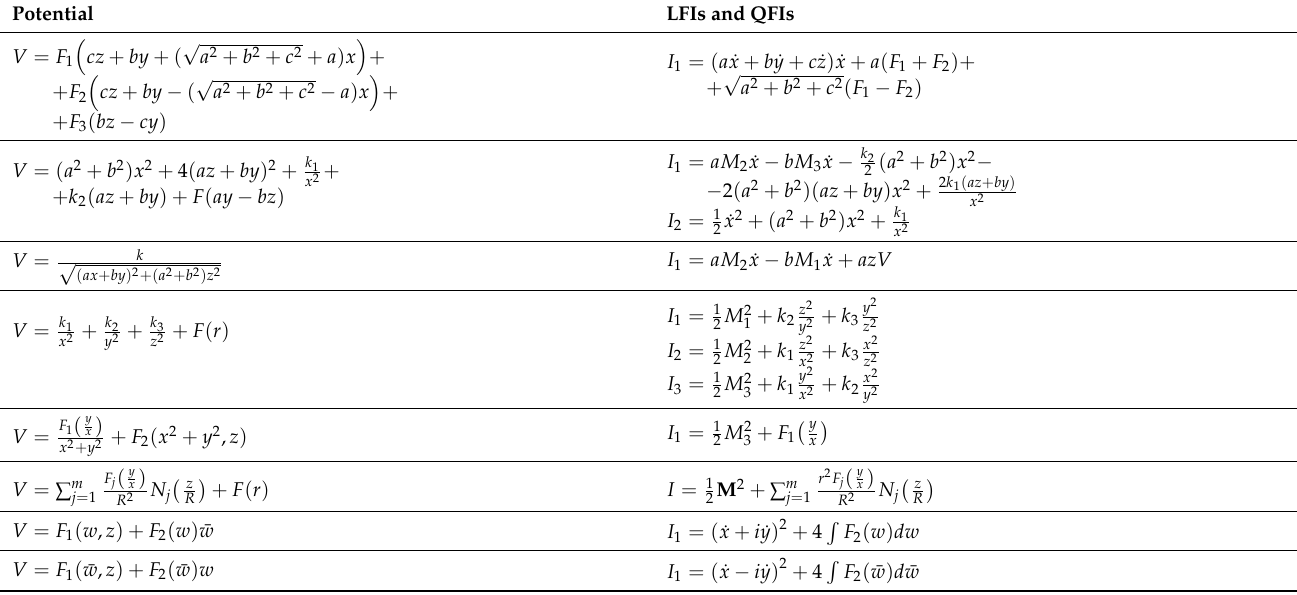
Table 4. Possibly non-integrable potentials V ( x , y , z ) in E 3 that admit one or more QFIs of the type I ( 1,1 ) which are not in involution.